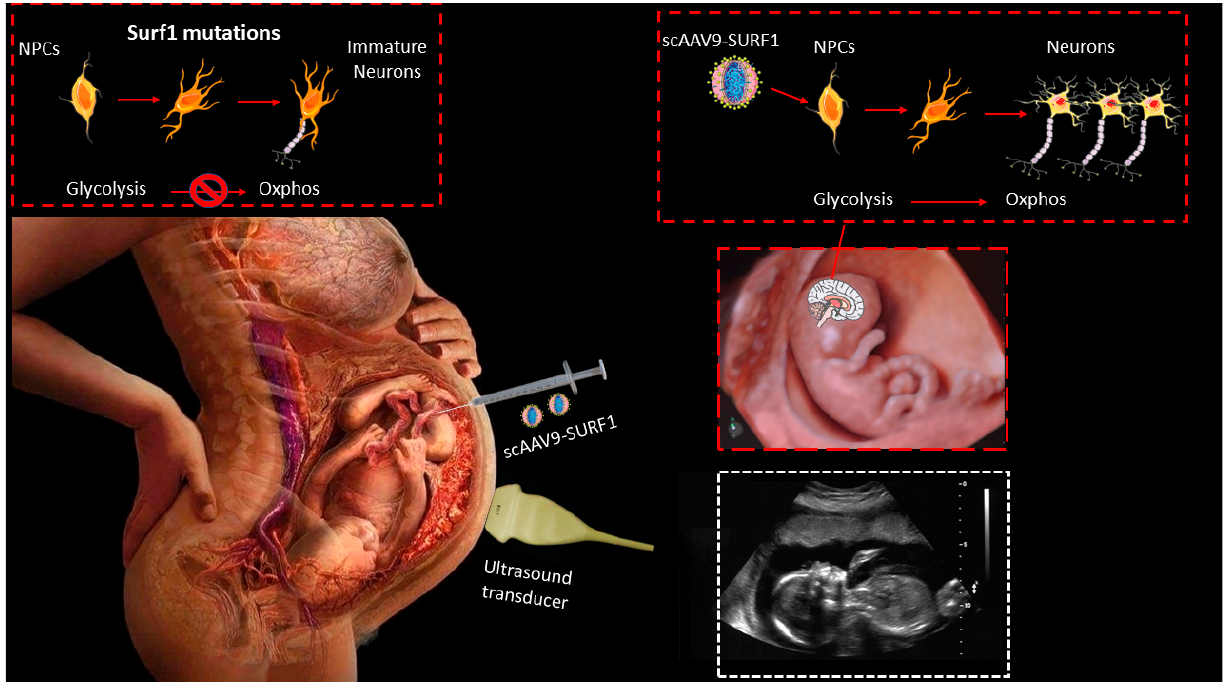
Figure 4. Schematic representation of IUFGT to restore correct neurodevelopment in Surf1 LS- affected fetus. The therapeutic gene can be delivered to the fetus through transabdominal intrauterine ultrasound-guided injection of AAV9-Surf1 in the fetal umbilical cord vessels. Figure